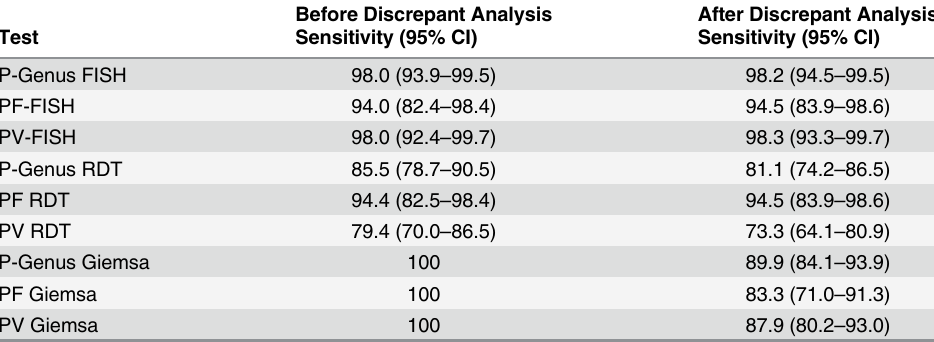
Table 3. Sensitivity of Plasmodium FISH tests and RDTs as compared to Giemsa. After discrepant anal- ysis: Including FISH and PCR positive but Giemsa negative samples as true positives. ” P-Genus FISH -17; PF-FISH – 5; and PV-FISH – 14. CI — confidence interval.